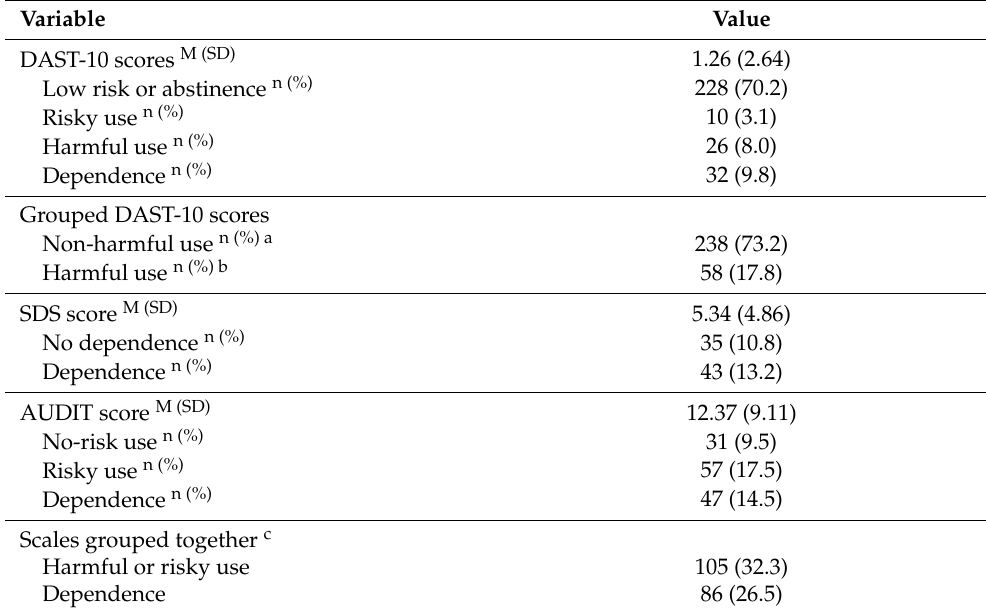
Table 3. Results of the instruments for measuring drug